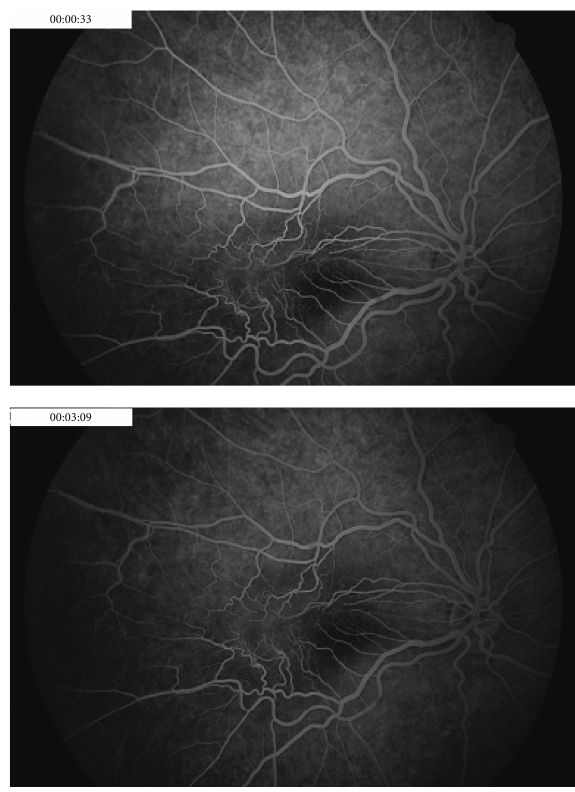
Figure 4: Fluorescein angiography of the right eye, prior to spontaneousresolution.Severevasculartortuositywithmildleakage after three minutes of fluorescein injection.